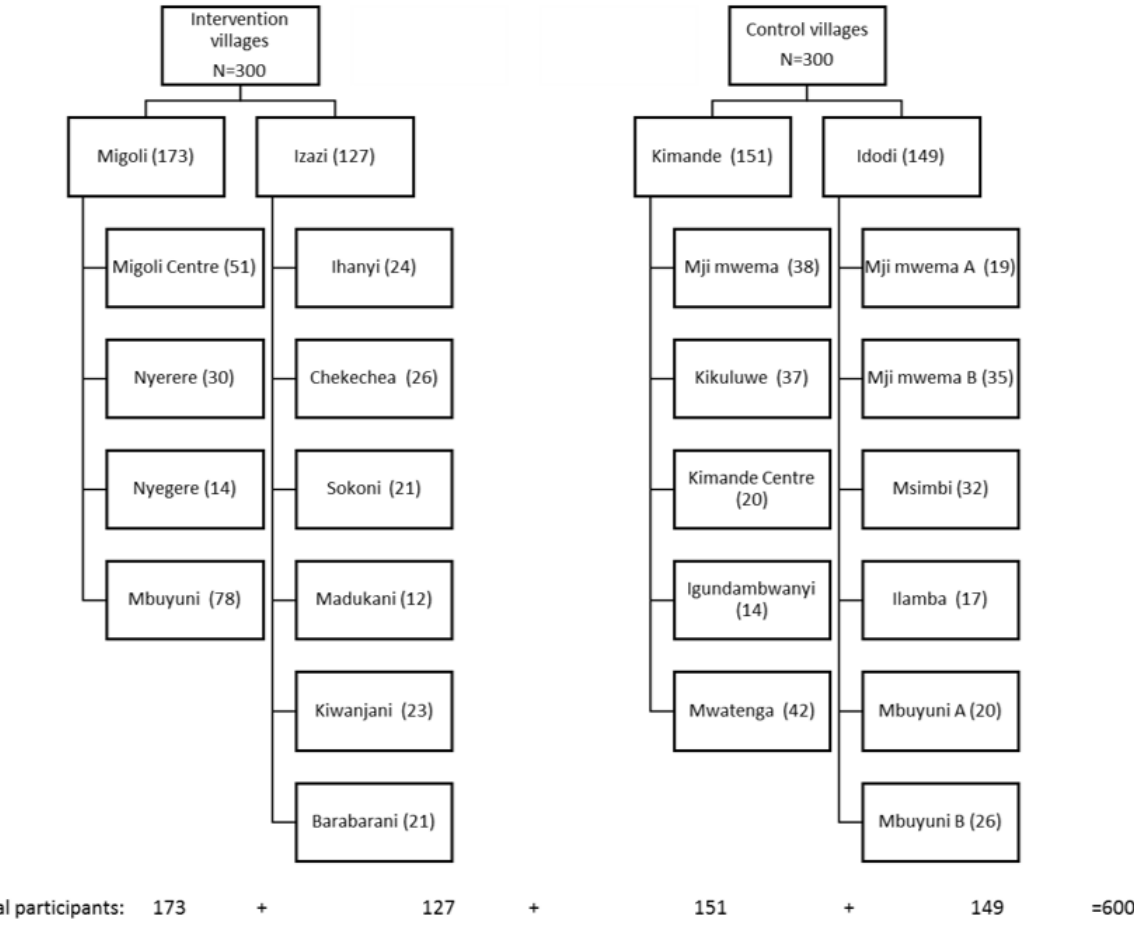
Figure 1. Participants from the respective groups, villages, and